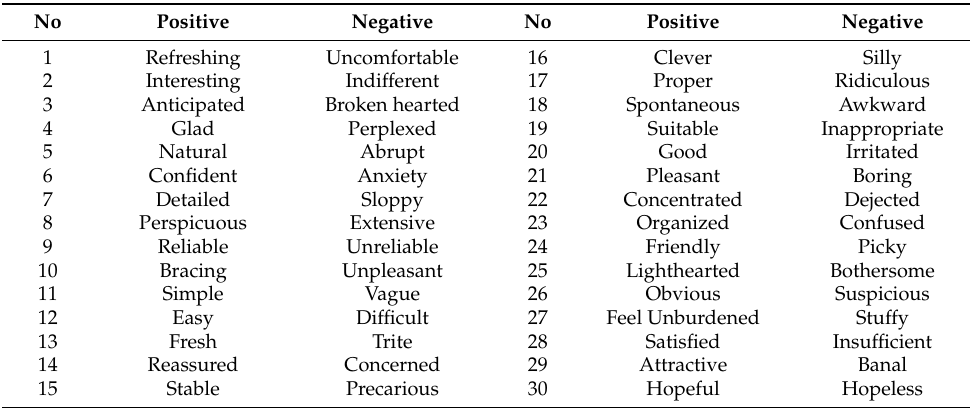
Table 2. Pairs of Kansei